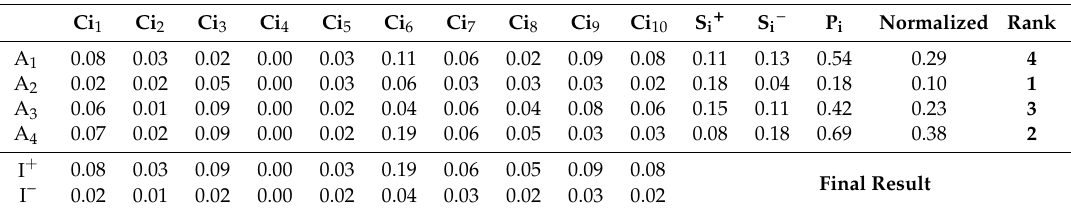
Table 21. The final result of the judgments